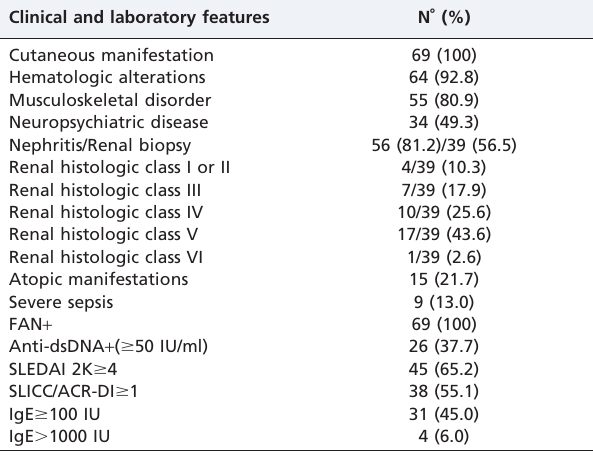
Table 1 - Clinical and laboratory findings in 69